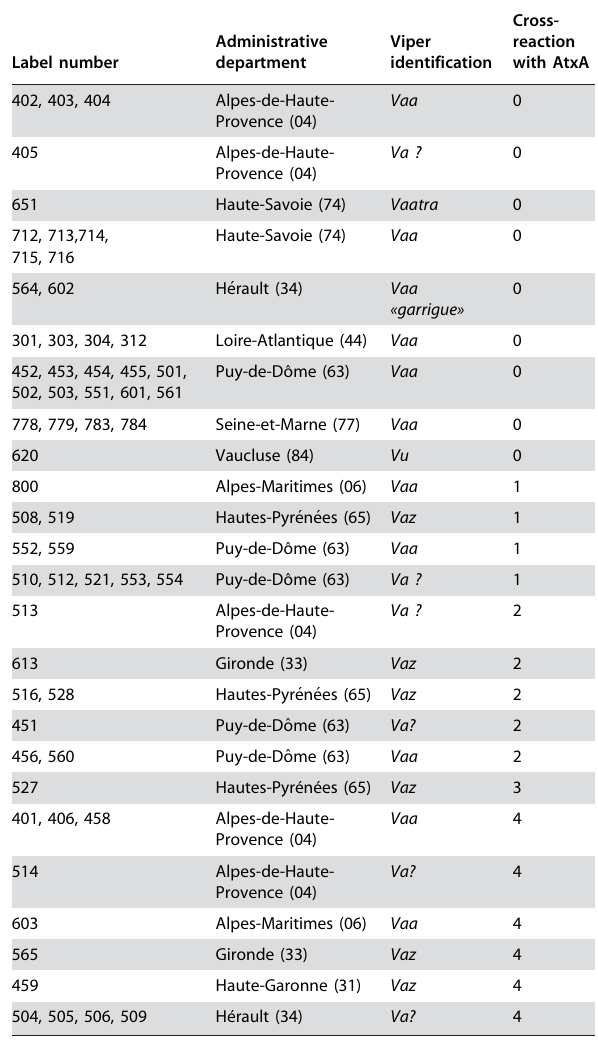
Table 3. Evaluation of neurotoxicity of venoms collected